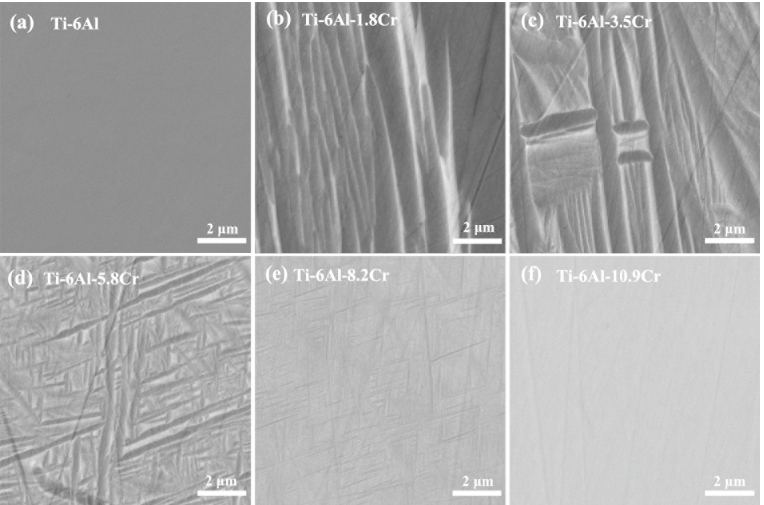
Figure 2. SEM, backscattered electron images of Ti-6Al-xCr alloys, taken from (Ti-6Al)–(Ti-6Al-20Cr) diffusion couple, after quenching at 1100 °C.